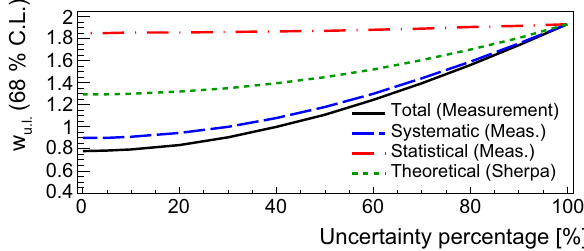
Fig. 3 Solidline: χ 2 asafunctionof w intheforwardrapidityregionin Sherpa NLO. Dashed line: Same but χ 2 obtained within the combined QCD calculation